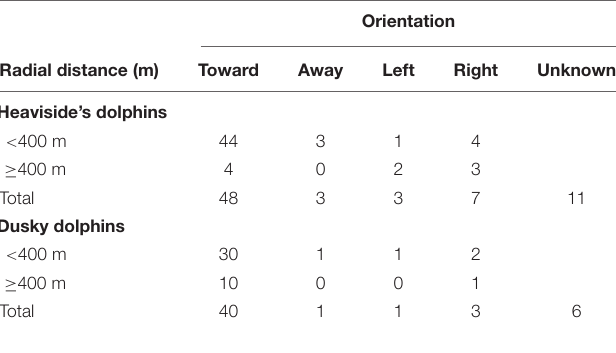
TABLE 1 | Orientation of dolphins with respect to distance from all visual sightings made on search effort.